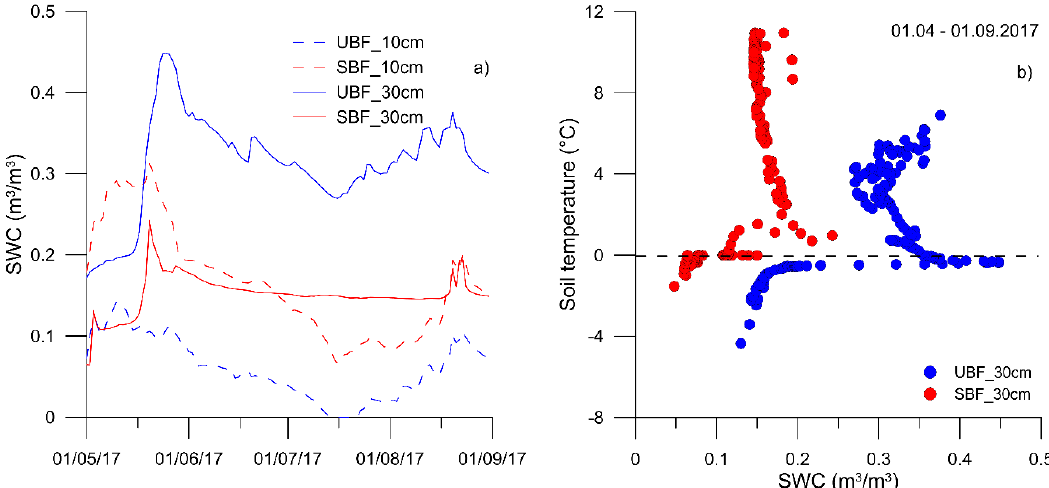
Figure 8. Soil water content (SWC) at 10- and 30-cm depths at UBF and SBF sites during the thawing season 2017 ( a ) and its relationship with soil temperature ( b ).